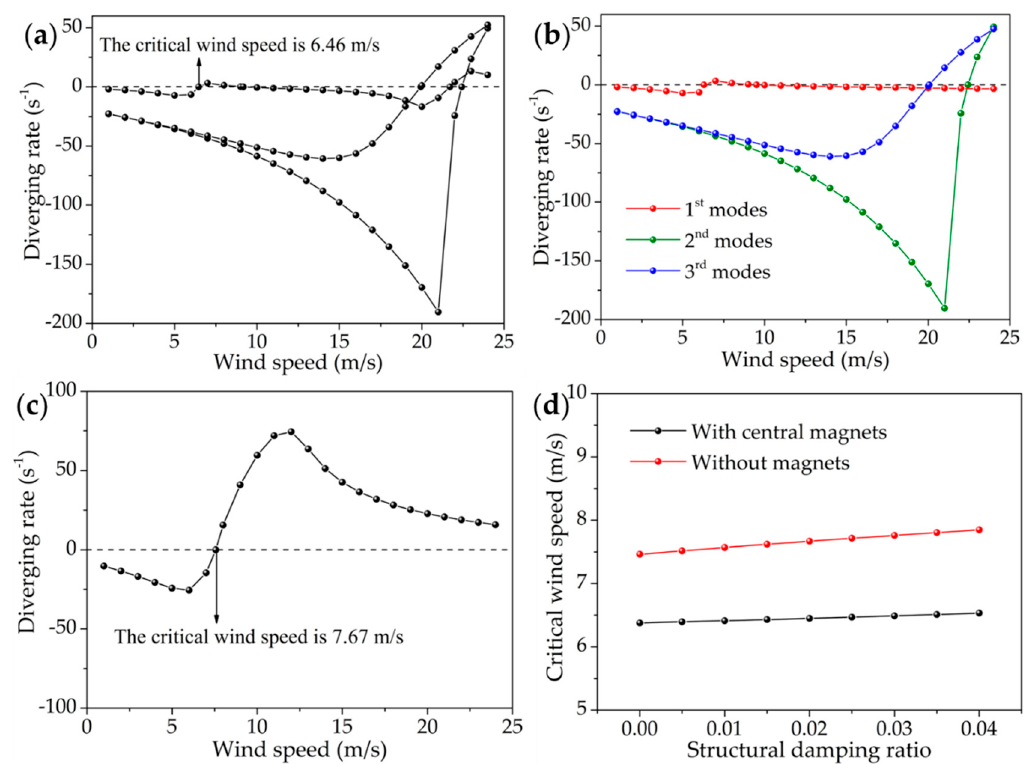
Figure 3. ( a ) The diverging rate as a function of wind speed when all the first three bending and torsional modes are involved in the calculation. ( b ) The diverging rate as a function of wind speed when the first, second, and third bending and torsional modes are involved in the calculation, respectively. ( c ) The diverging rate as a function of wind speed when there is no magnet attached to the PET membrane. ( d ) The relationship between the critical wind speed and the structural damping ratio.